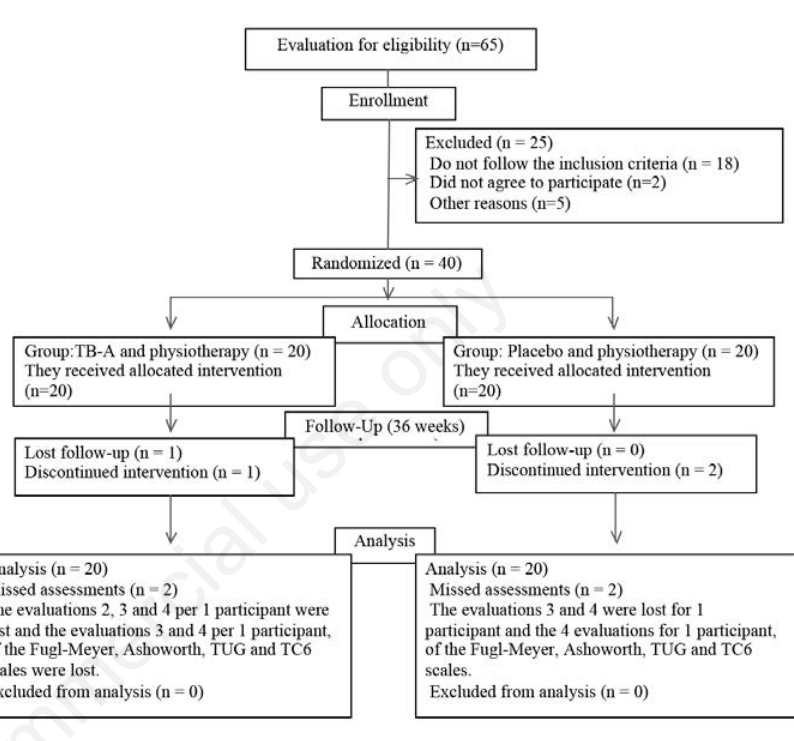
Figure 1. Recruitment process, randomization, allocation, follow-up and analysis regard- ing the participants of the groups.